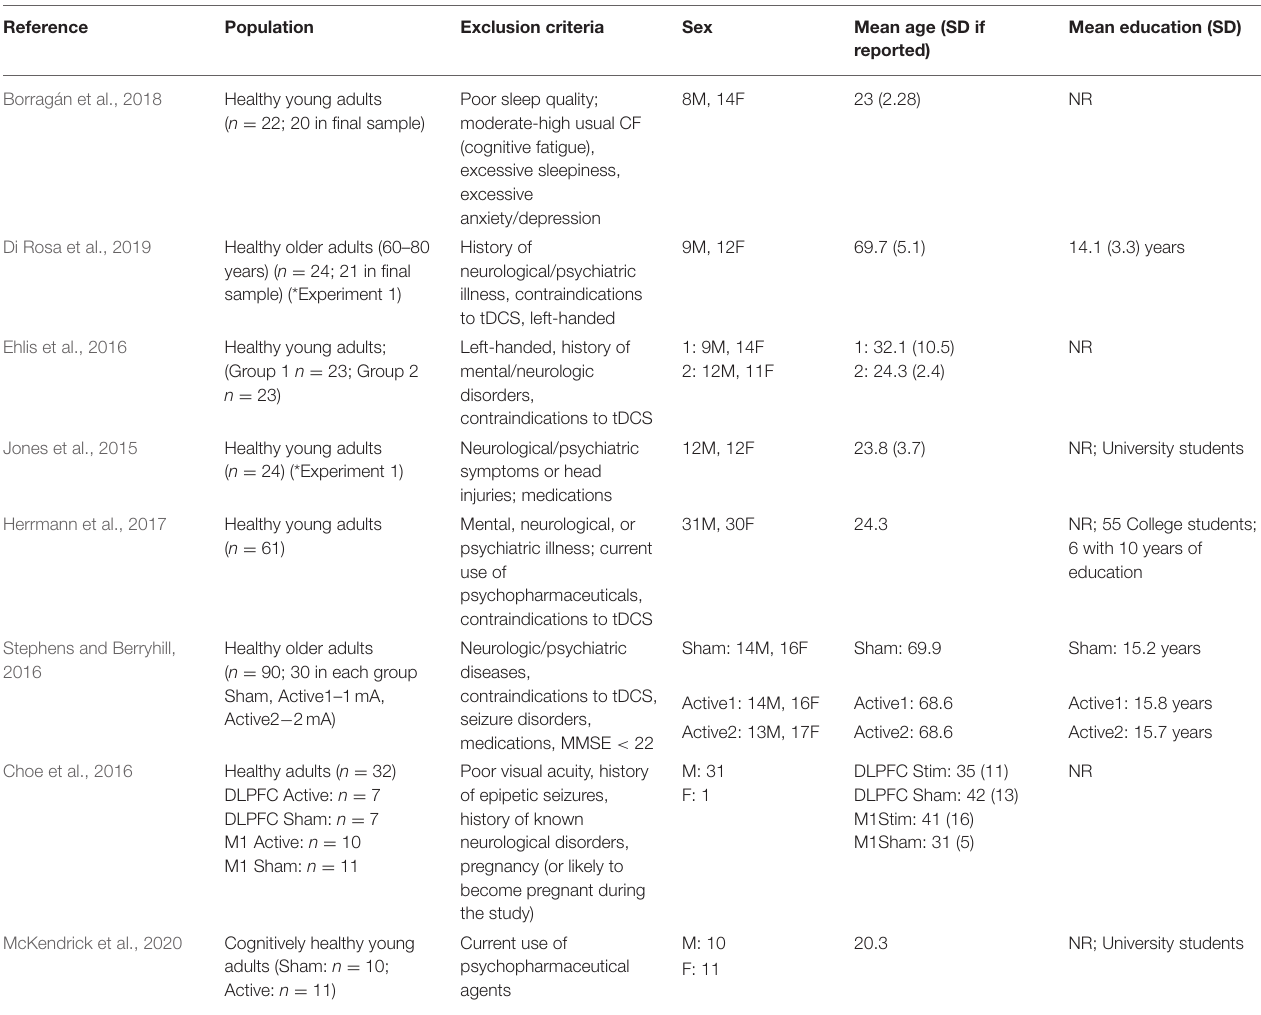
TABLE 1 | Characteristics of participants.